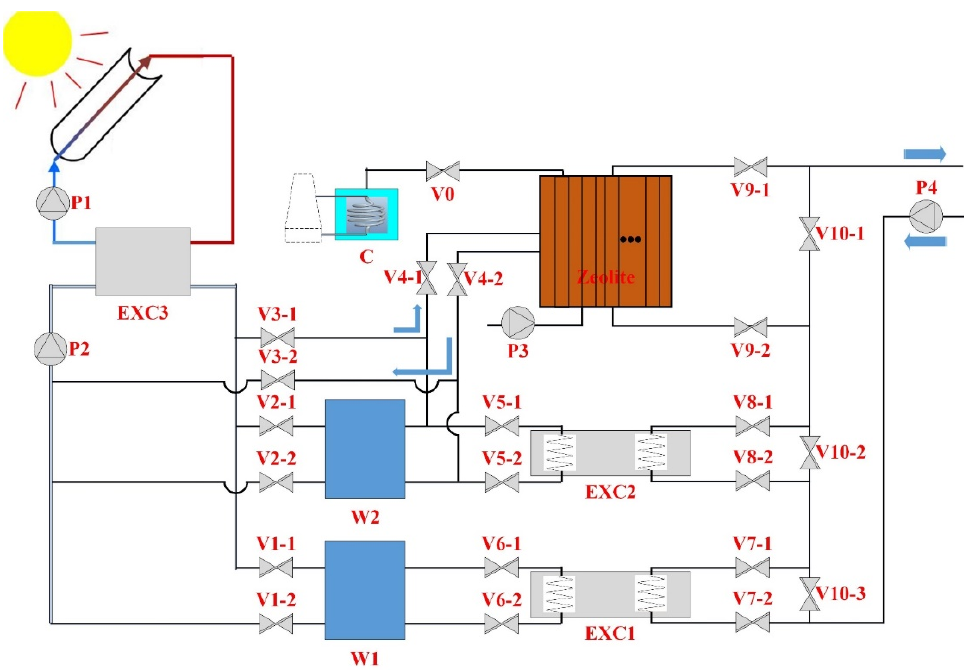
Figure 1. Schematic of the proposed system.